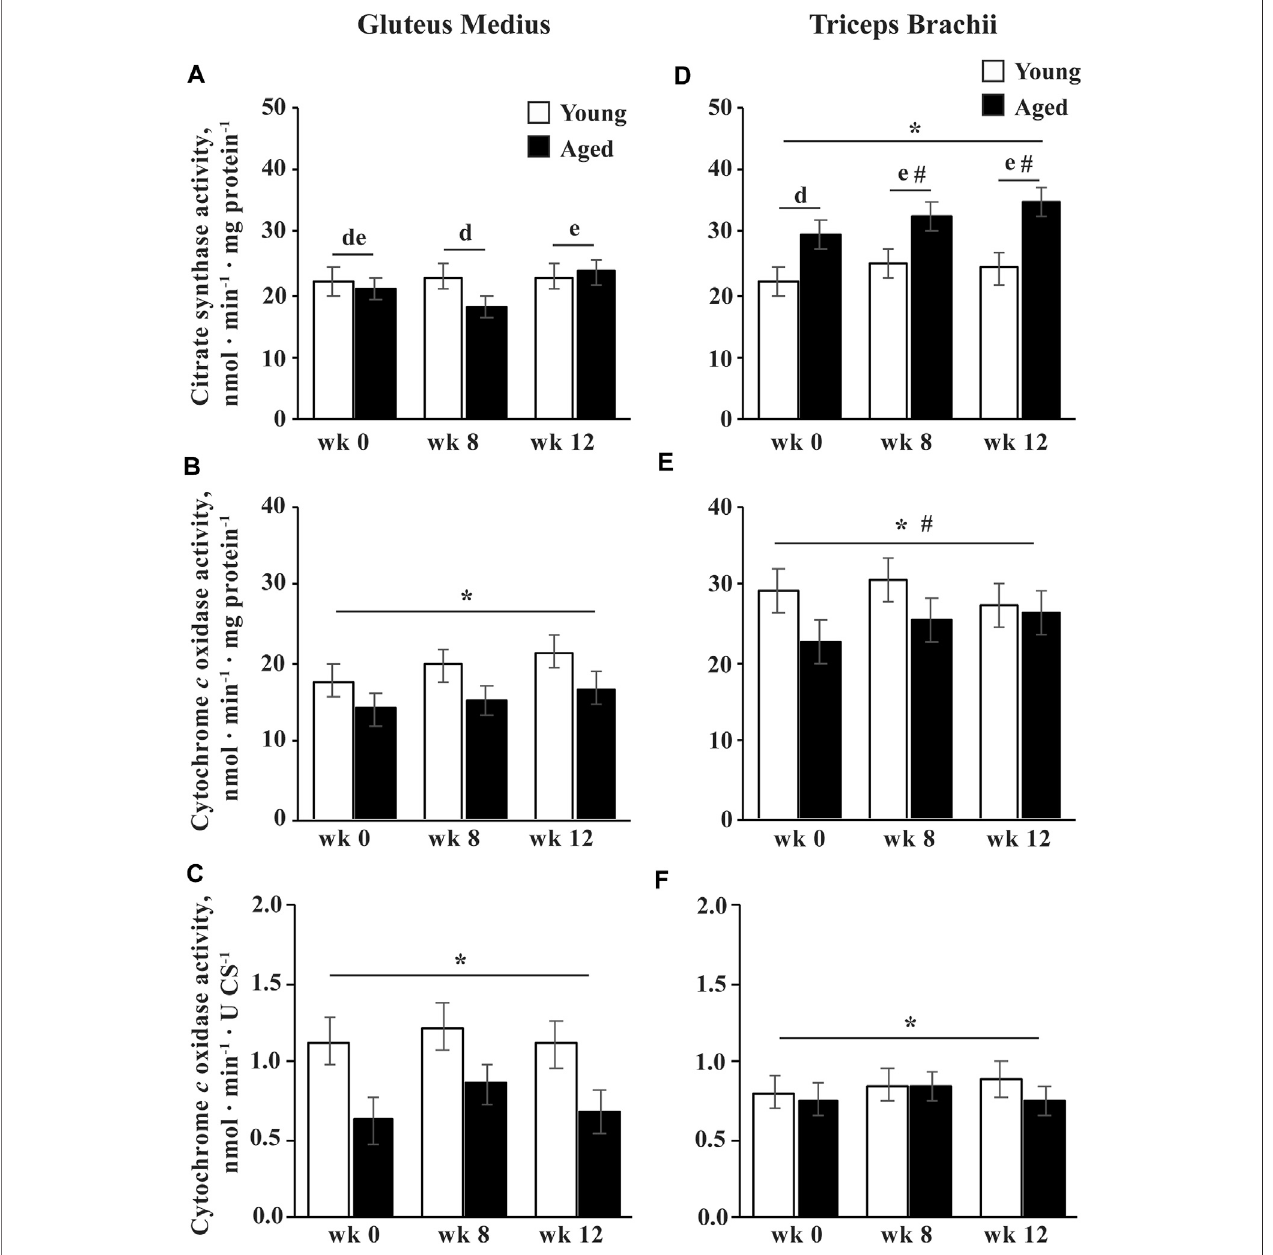
FIGURE4| Gluteusmedius andtricepsbrachiicitratesynthase(CS) activity (A , D) ,and integrative (permgprotein; B , E )and intrinsic(perunitCS; C , F ) cytochrome c oxidase(CCO)activitiesbefore(wk0),andafter8(wk8)and12(wk12)weeksofsubmaximalexercisetraininginaged(22 ± 4.5yr; n (cid:1) 10)andyoung(9.7 ± 0.7mo; n (cid:1) 8) horses. Overall effect of age ( p (cid:1) 0.3; p (cid:1) 0.04; p (cid:1) 0.02), training ( p (cid:1) 0.01; p (cid:1) 0.09; p (cid:1) 0.13), muscle group ( p (cid:1) 0.0008; p < 0.0001; p (cid:1) 0.93), age × training ( p (cid:1) 0.06; p (cid:1) 0.3; p (cid:1) 0.4),age × musclegroup( p (cid:1) 0.0007; p (cid:1) 0.2; p (cid:1) 0.14),training × musclegroup( p (cid:1) 0.02; p (cid:1) 0.4; p (cid:1) 0.6),andage × training × musclegroup( p (cid:1) 0.11; p (cid:1) 0.96; p (cid:1) 0.99) for CS activity, integrative CCO activity, and intrinsic CCO activity, respectively. * Within muscle group, aged differs from young ( p < 0.05). # Within week, GM differs from TB ( p < 0.05). d,e Within muscle group, time points with different letters differ ( p <